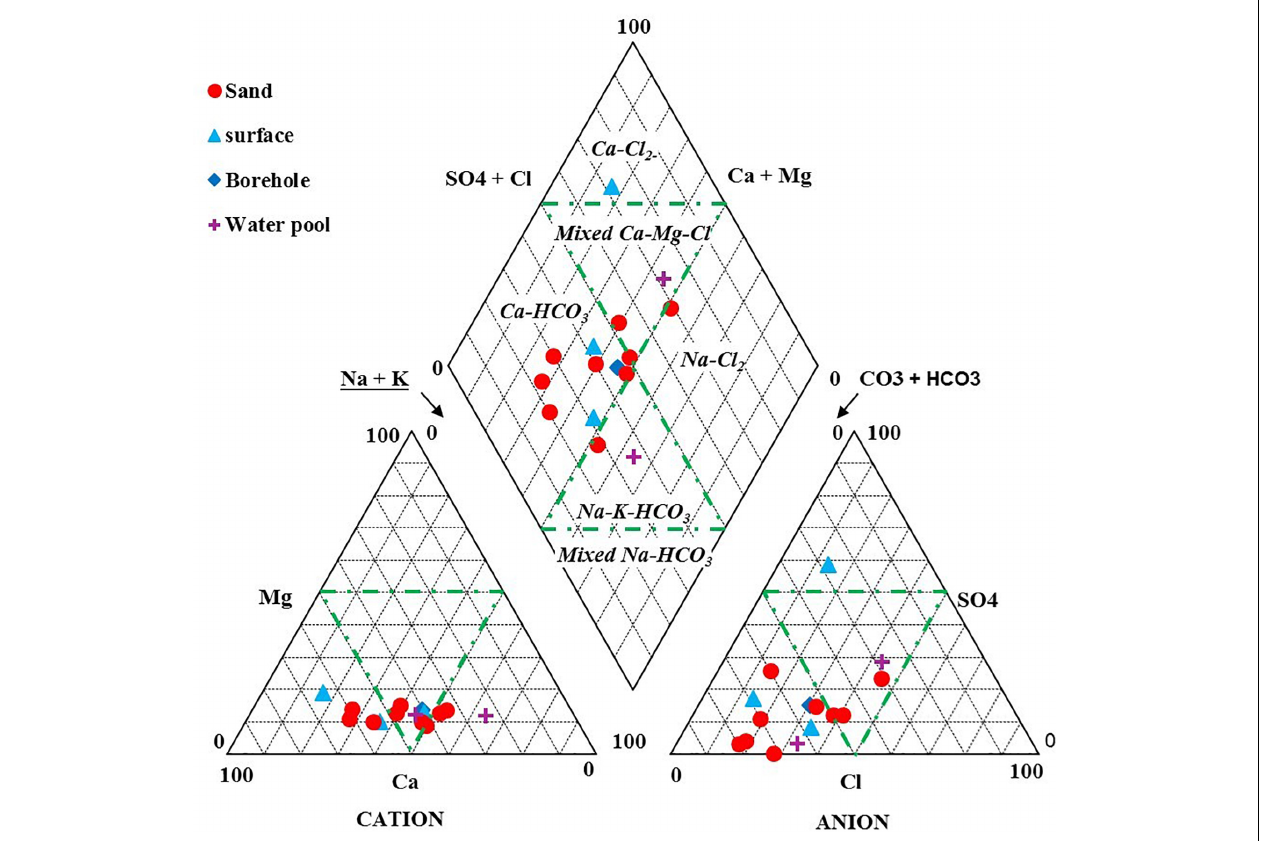
( Figure 8E ), the admissible maximum concentration based on WHO guidelines. The relationship between sodium and chloride gives even more insights into the hydrogeological processes recharged water ( Figure 8B